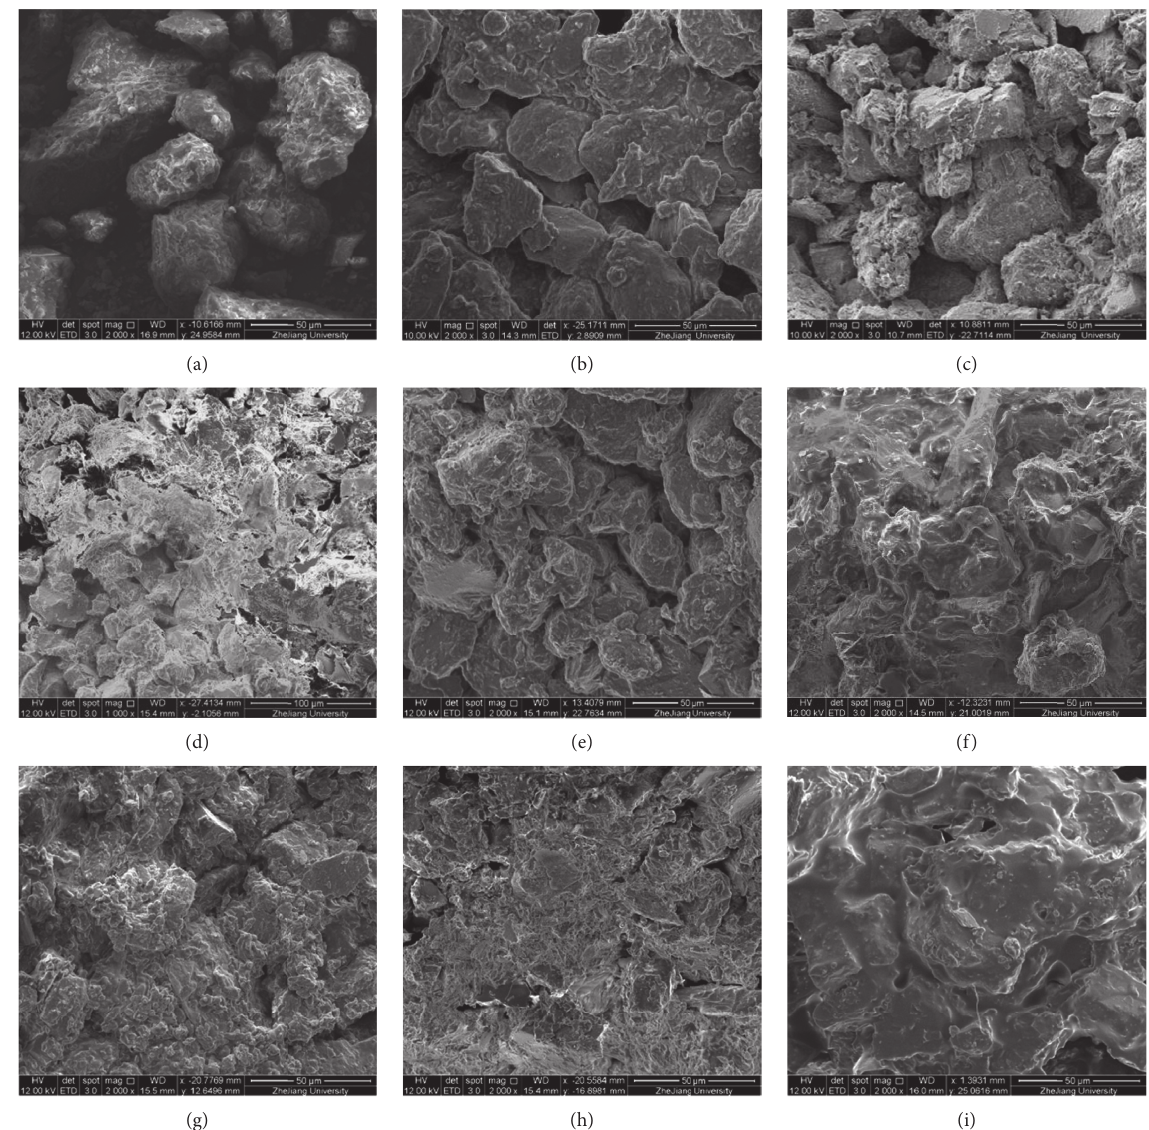
Figure 9: 2000 × SEM results of the specimens mixed in different mass ratio (7 days, 20 ° C, and 50% humidity). (a) T T 0 R 5 S 95 . (d) T 5 R 5 S 90 . (e) T 5 R 10 S 85 . (f) T 10 R 5 S 85 . (g) T 10 R 10 S 80 . (h) T 5 R 15 S 80 . (i) T 15 R 5 S 80